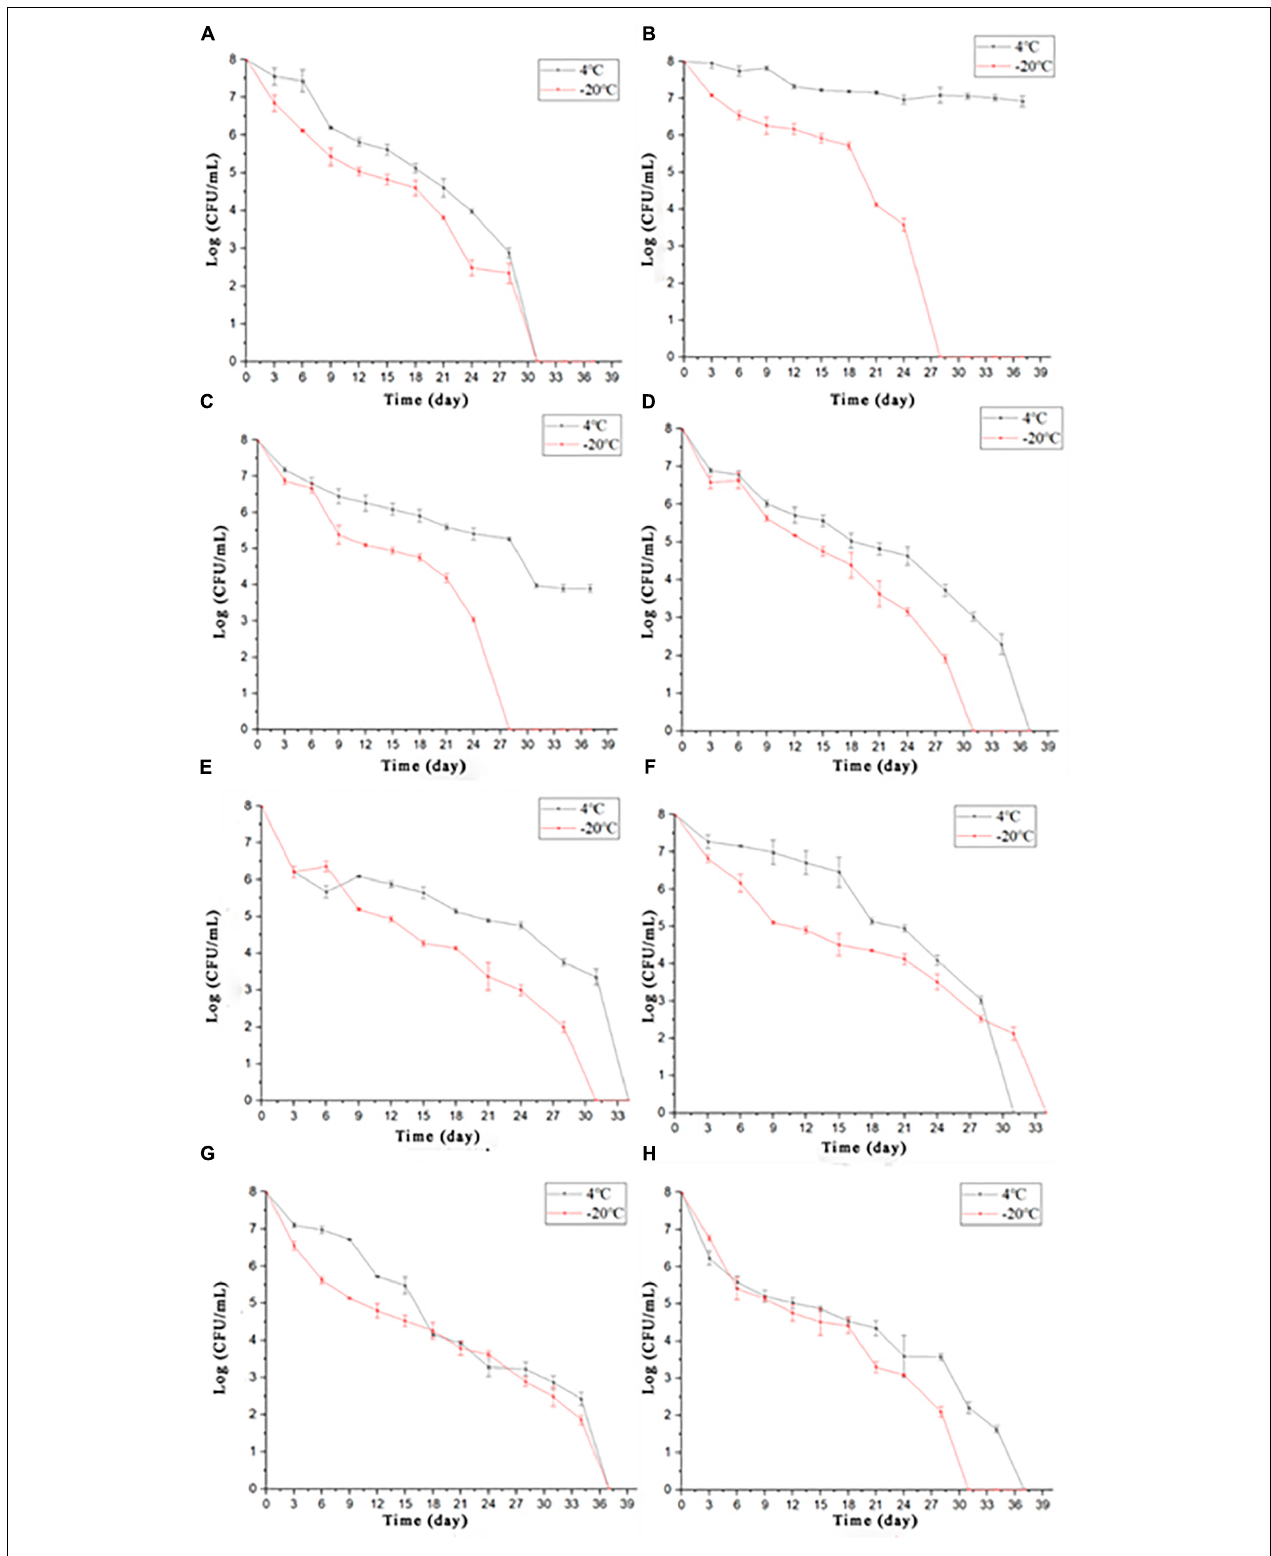
FIGURE 3 | The culturable number of Salmonella stored under 16 different conditions ( A–H were the culturable number tendency of Salmonella under correspondent conditions according to methods 1, 2, 5, 7, 9, 10, 13, and 14 and stored at 4 ◦ or − 20 ◦ C, respectively).